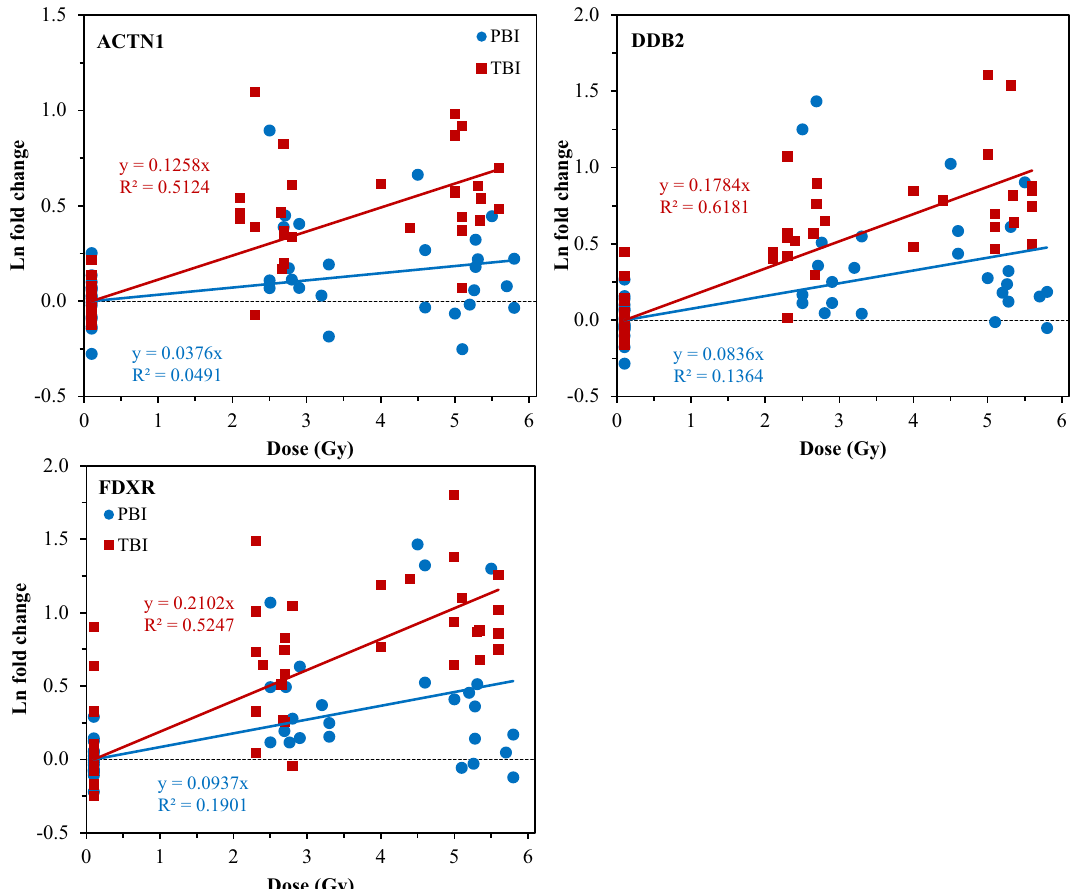
Figure 4. Radiation dose responses (ln-transformed fold changes relative to unexposed mice) for three protein biomarkers (ACTN1, DDB2, FDXR) after TBI or PBI. The black dotted line represents zero ln fold change and indicates the